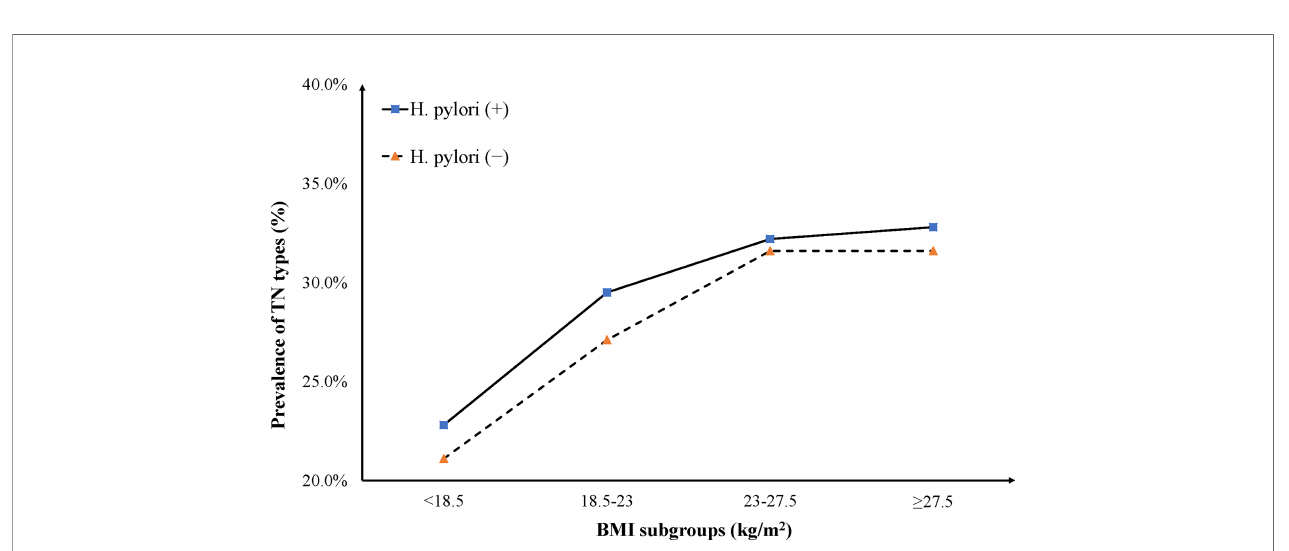
FIGURE 1 | The prevalence of TN types increased with age in both H. pylori (+) and H. pylori (-) groups. Among the fi ve age ranges, only in the 50-59 years subgroup, the prevalence of TN types in the H. pylori (+) group was statistically lower than that in the H. pylori (-) group. However, in other age subgroups, no signi fi cant difference was found in the prevalence of TN types between H. pylori (+) and H. pylori (-)